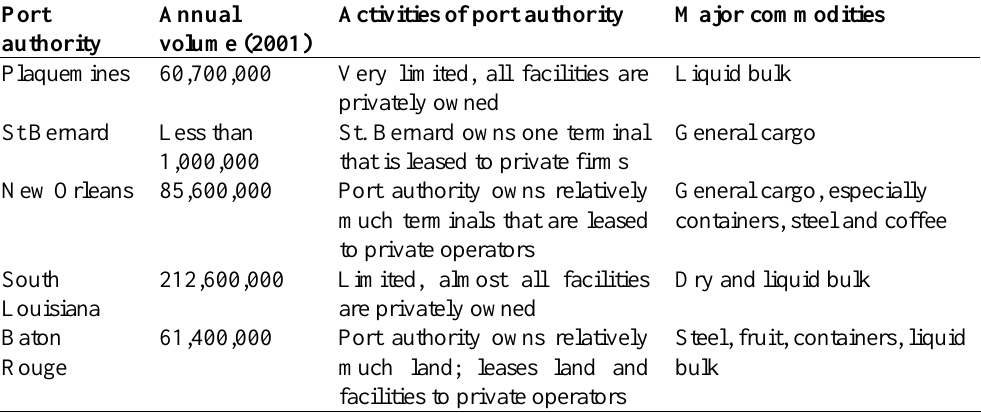
Table 7. Description of the port authorities in the